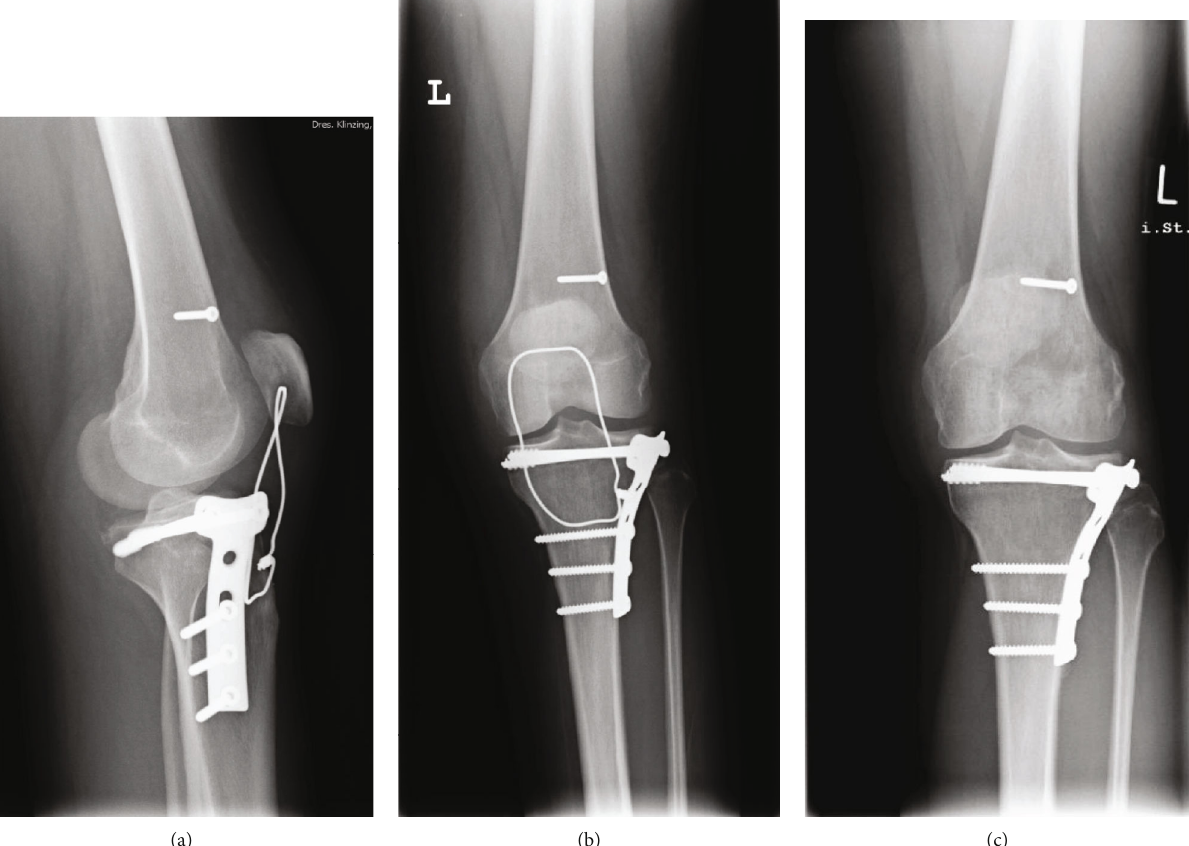
Figure 3: Radiographic result after the operation (a, b) and after the removal of the McLaughlin wire